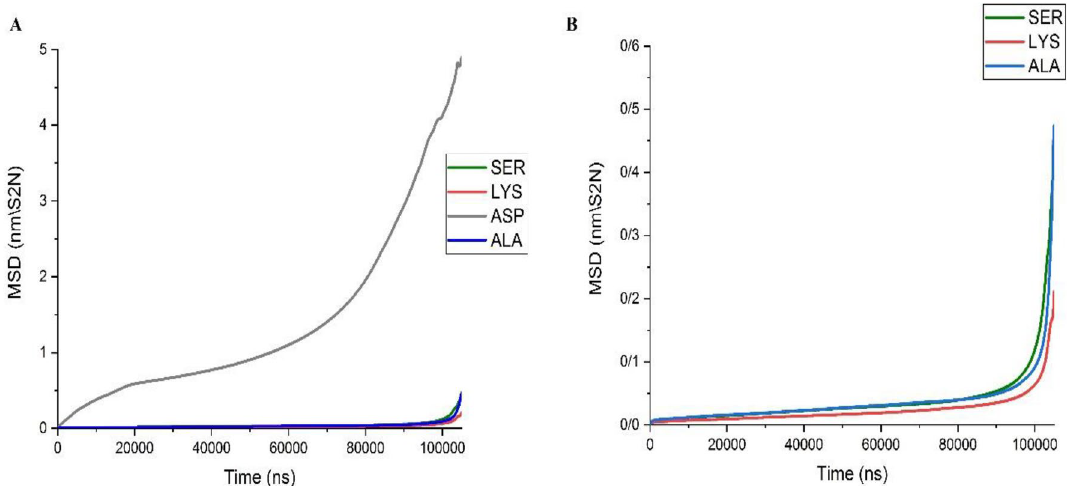
Figure 4. The MSD curves for the amino acids investigated in the simulated